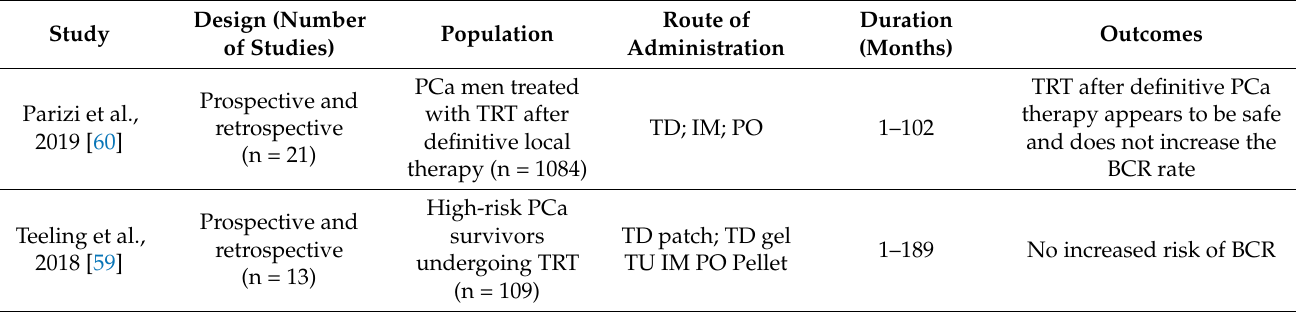
Table 1. Meta-analyses evaluating the risk of BPH and PCa development in patients undergoing